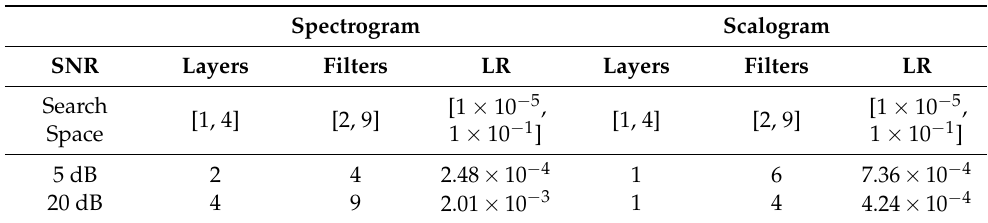
Figure 4. A network structure example. The number of filters N f and the number of convolutional layers N l were determined through Bayesian optimization. Each convolutional layer was followed by batch normalization, max pooling, and an ReLU activation function. The second-to-last layer was a fully connected layer with 128 neurons. The last layer was a fully connected layer with a number of neurons equal to the number of classes (four in this depiction). Table 4. Number of convolution layers and filters and the initial learning rates (LRs) for the CNN chosen through Bayesian optimization for classification of the geometry (sphere or shell). The hyperparameter search space is also reported.